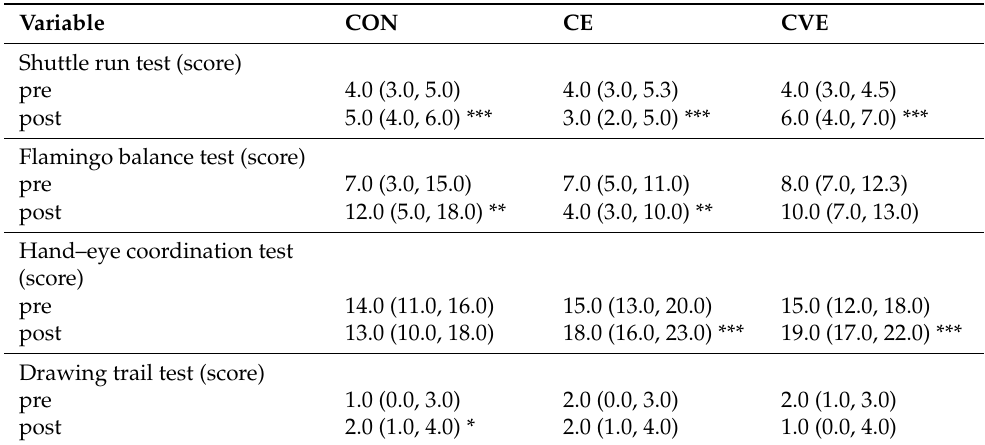
Table 3. Median values (25th and 75th percentiles) for cardiovascular endurance, gross motor and fine motor skills in the two experimental (CE and CVE) groups and the control group (CON).